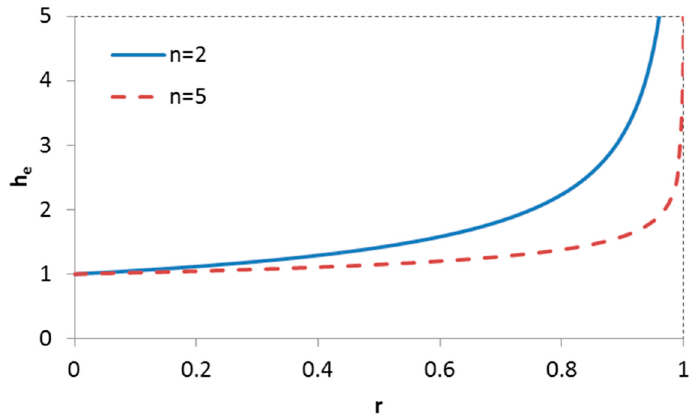
Figure 4. Influence of the power n on the dynamic morphological equilibrium.